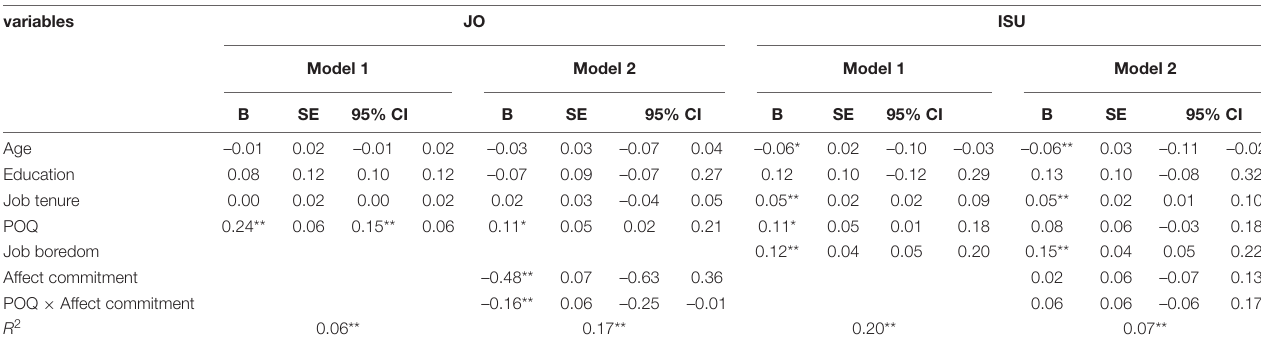
TABLE 3 | Results for the moderated mediation